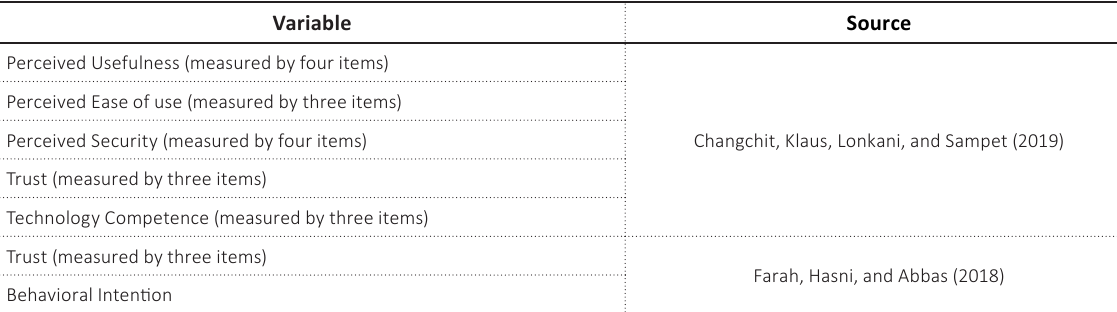
Table 1. References to the sources of accepted questionnaires